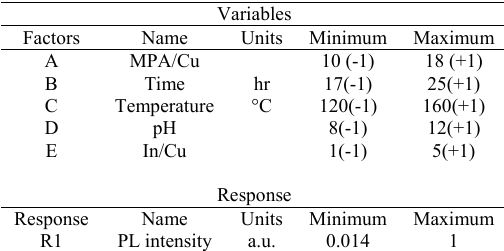
Table 1: The dependent and independent variables Table 1. The dependent and independent variables